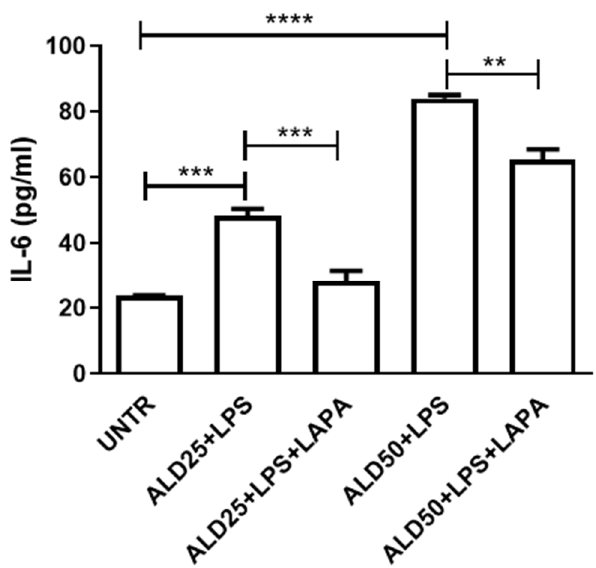
Figure 4. Analysis of IL-6 levels on supernatants of RAW 264.7 treated with ALD 25 µ M or 50 µ M plus 10 µ g/mL LPS, with or without 10 µ M Lapaquistat (LAPA). Data are expressed in pg/mL and indicated as mean ± SD of three independent experiments analyzed with ANOVA and corrected with Bonferroni post-test: ** p < 0.01, *** p < 0.001, **** p < 0.0001. UNTR: untreated.